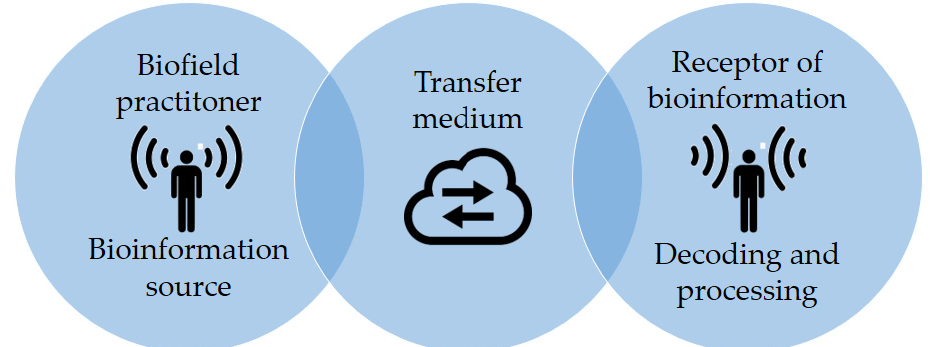
Figure 1. Hypothetical bioinformation transport mechanism established during a non-contact biofield intervention (adapted from [19]). Description: the biofield practitioner generates bioinformation signals carried in the transfer medium, reaching the receiving person whose homeostatic system decodes and physiologically process the information.